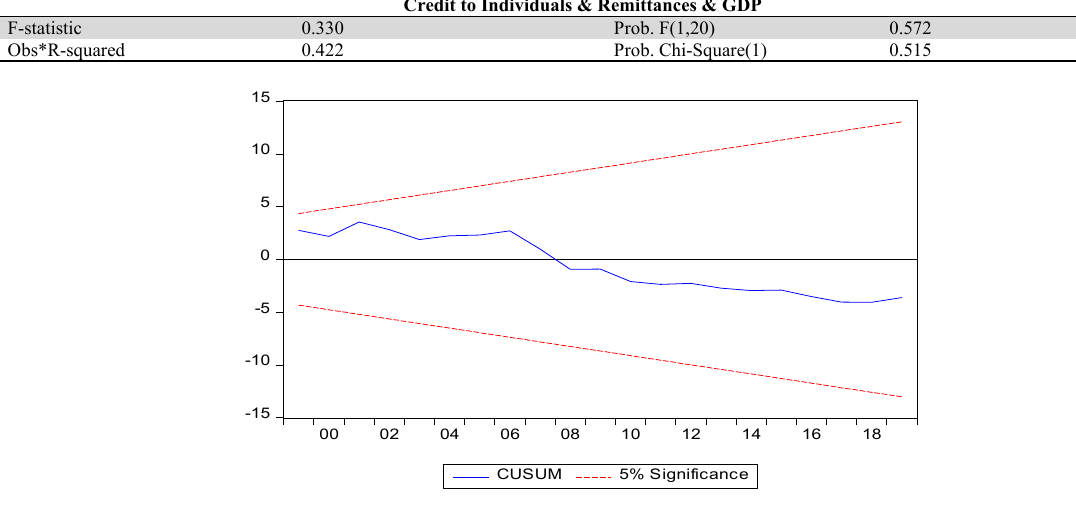
Fig. 6. CUSUM Test: Bank Credit to Individuals & Remittances &